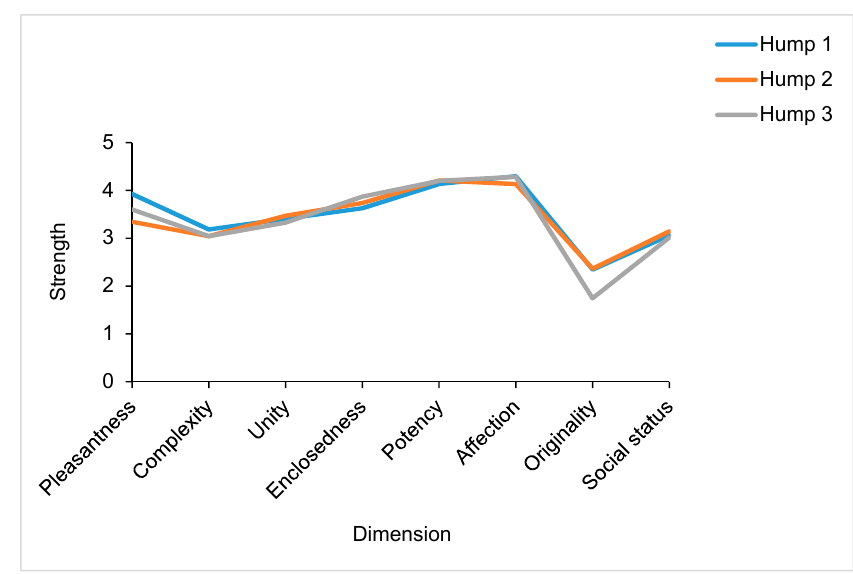
Figure 5. Mean values per hump of the eight different dimensions in the Semantic Environmental Description (SED). Y-axis shows the strength for each dimension (0 = smallest, 5 = largest). Table 5. Results of two-way ANOVA (analysis of variance) of the eight dimensions in Semantic Environmental Description (SED), testing effects of humps and order of hump presentation in the questionnaire. df = degrees of freedom, F = F value, p = significance level.